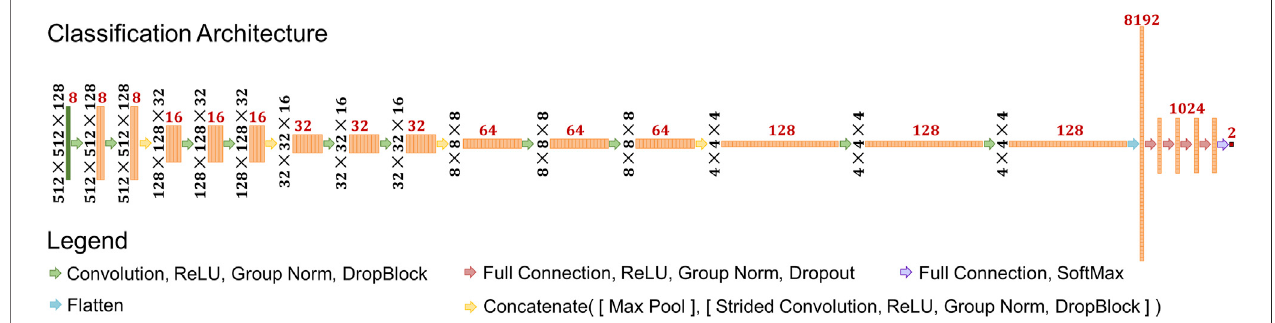
FIGURE 2 | Schematic of deep learning architecture used in the study. Black numbers represent the feature shape of each layer prior to the fl attening operation. Red numbers represent the number of features at each